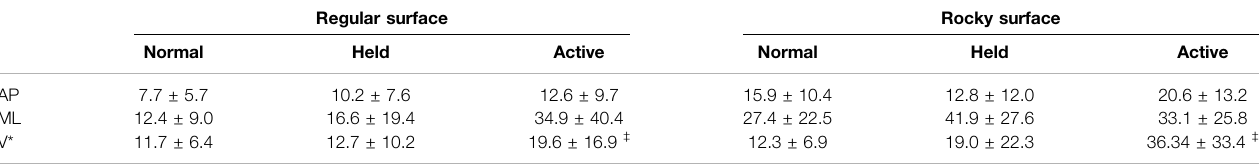
TABLE 2 | Trunk angular velocities (x10 − 2 ° /s) according to surface type and arm swing strategy in all three directions. Regular surface Rocky surface Normal